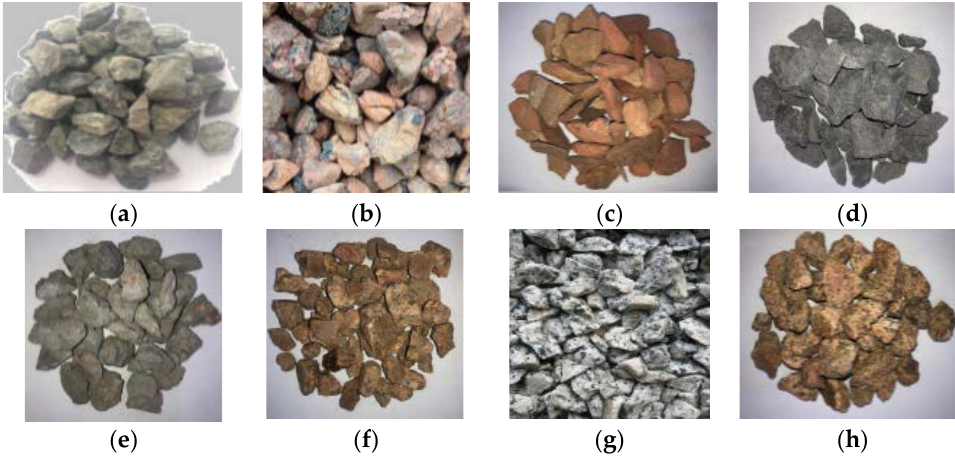
Figure 1. Appearance of the different coarse aggregates: ( a ) NCA; ( b ) SCC; ( c ) SCG; ( d ) UCG; ( e ) RCA; ( f ) IWR; ( g ) MSW; ( h ) GSW.